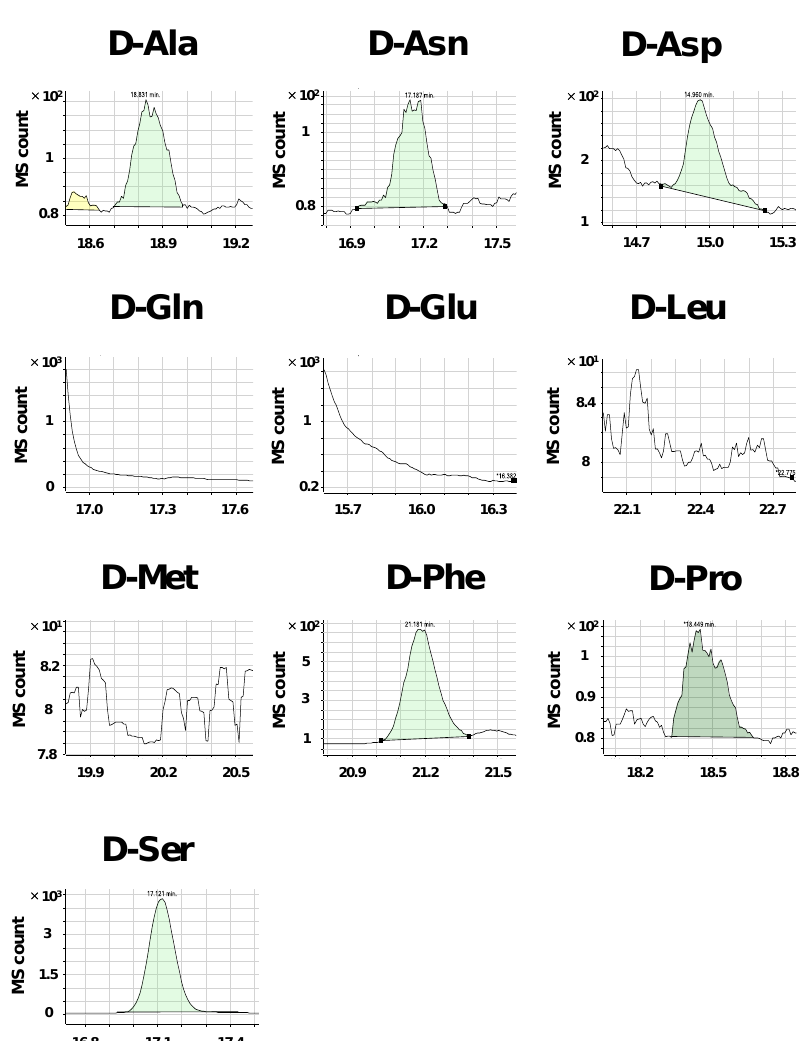
Figure 4. Chromatograms of derivatized D -amino acids in the murine cortex samples. Tissue samples were extracted from the cortices of 3-month-old mice. Representative MRM chromatograms of derivatized D -amino acids are shown. In each panel, relative ion abundance (MS counts) versus retention time (min) are shown. Integrated MS count (green) represents the amount of target molecules.